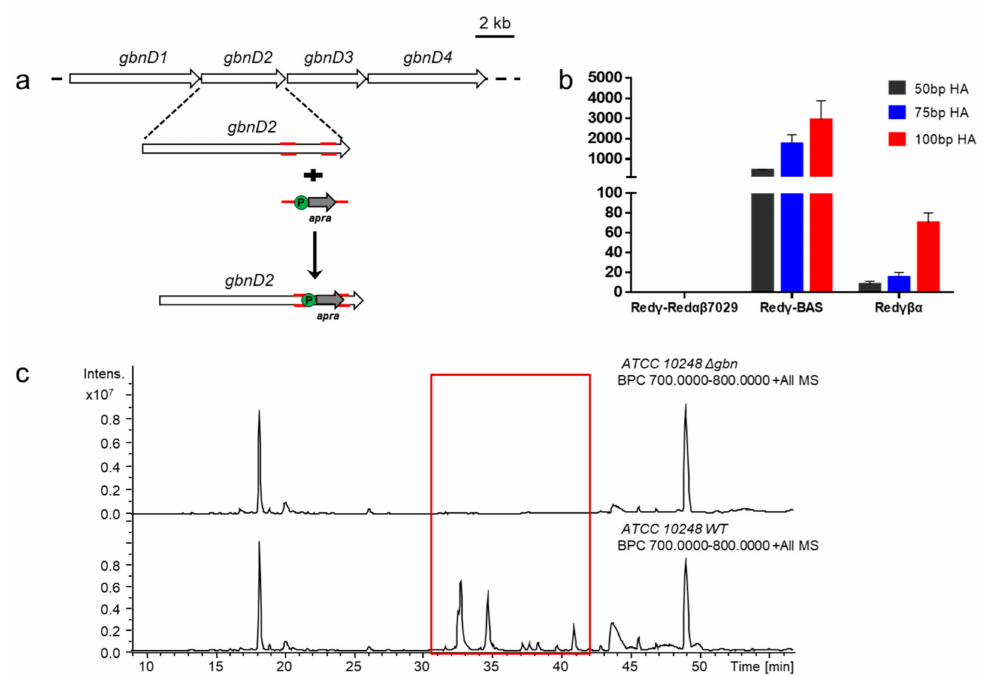
Figure 2. Assay of recombination systems in B. gladioli ATCC 10248. ( a ) Diagram of knockout of gladiolin gene cluster in strain ATCC 10248. ( b ) Recombination efficiency comparison of three recombinases Red γ -Red αβ 7029, Red γ -BAS, and Red γβα . ( c ) Validation of gladiolin biosynthetic gene clusters (BGC) knockout through LC–MS analysis of the metabolic profiles of wild type and ∆ gbn